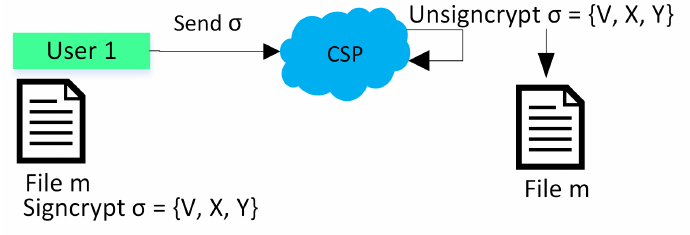
Figure 1. Proposed